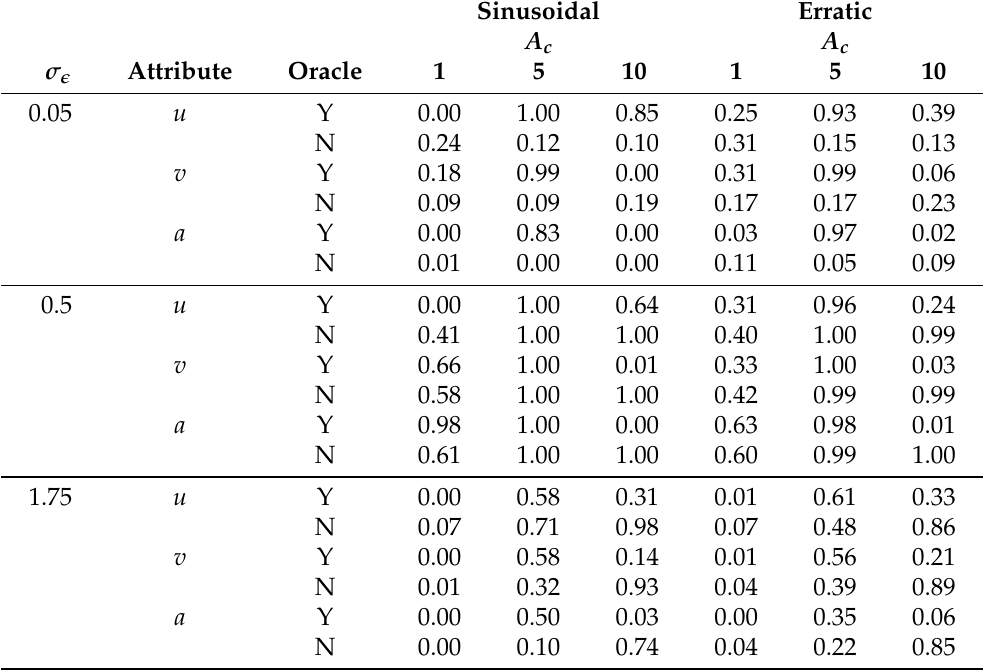
Table 4. Coverage probabilities of maximum values for u , v , and a for both Oracle and non-Oracle models. The models were trained on a sinusoidal training system with amplitudes A c = 1,3,5, force error σ (cid:101) = 0.05,0.5,1.75 and validated on both Erratic and Sinusoidal systems with Erratic system with typical validation amplitude of 5, created using Erratic system variances ψ 2 Sinusoidal parameters A p = 5, σ (cid:101) = 0.5. Based on 100